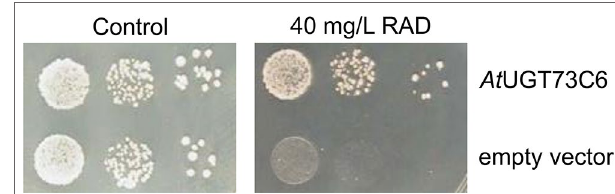
FIGURE 5 | Expression of Arabidopsis thaliana UDP-glucosyltransferase At UGT73C6 confers radicicol (RAD) resistance to yeast strain YZGA515. Spotting of YZGA515 transformants (three serial 10 −1 dilutions) expressing either At UGT73C6 (upper row) or containing the empty vector. Synthetic complete medium without leucine (SC-LEU) plates without added RAD (left) or with 40 mg/L